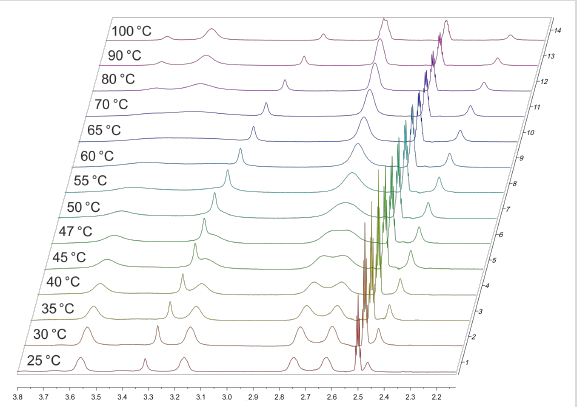
Figure 4: Temperature-dependent 1 H NMR spectra of 3a measured in DMSO- d 6 (aliphatic region of the piperazine protons from 2.00 to 4.00 ppm is shown).